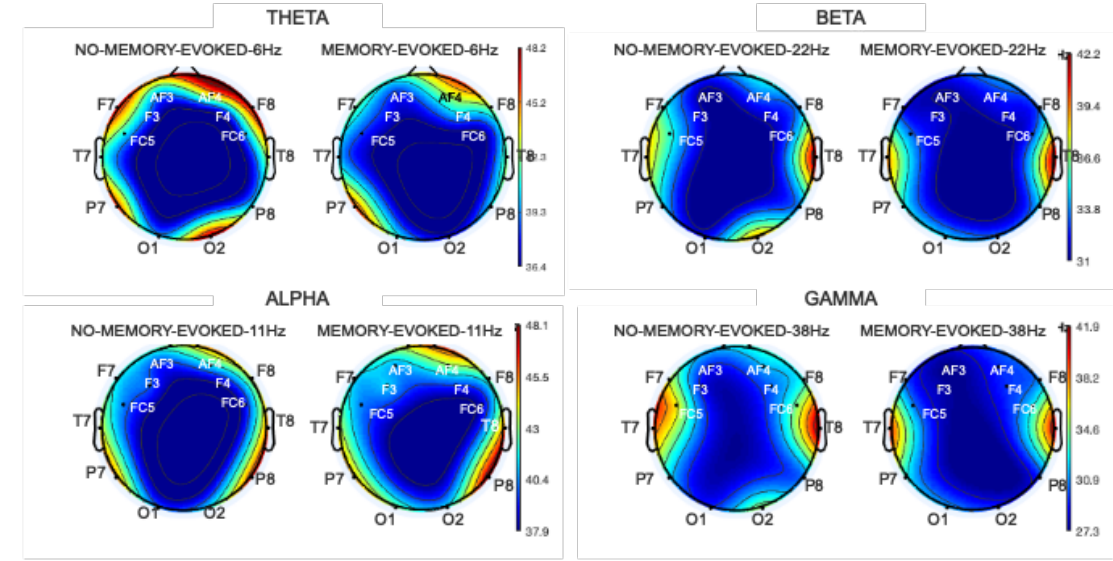
Figure 4. Spectral power map for participant P 1. For each frequency band: left, “NO-MEMORY- EVOKED”; right,